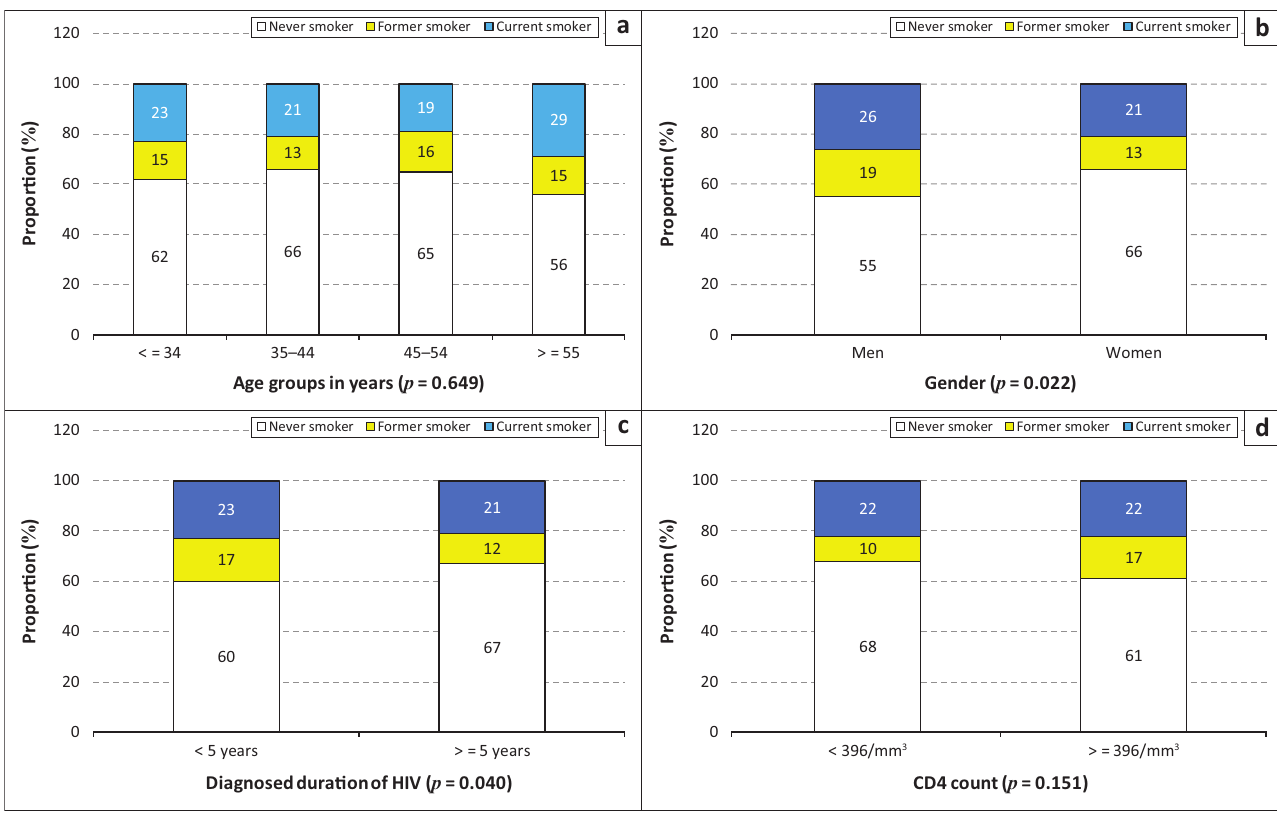
CD4, cluster of differentiation 4; HIV, human immunodeficiency virus. FIGURE 1: Smoking status in different subgroups defined by (a) age, (b) gender, (c) known duration of human immunodeficiency virus infection and (d) cluster of differentiation 4